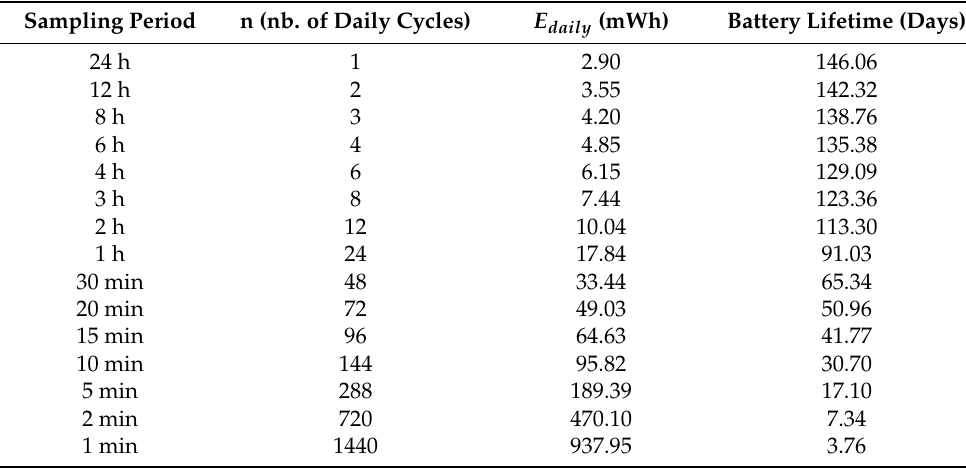
Figure 6. Current consumption log. Table 2. Battery lifetime depending on the number of daily sampling